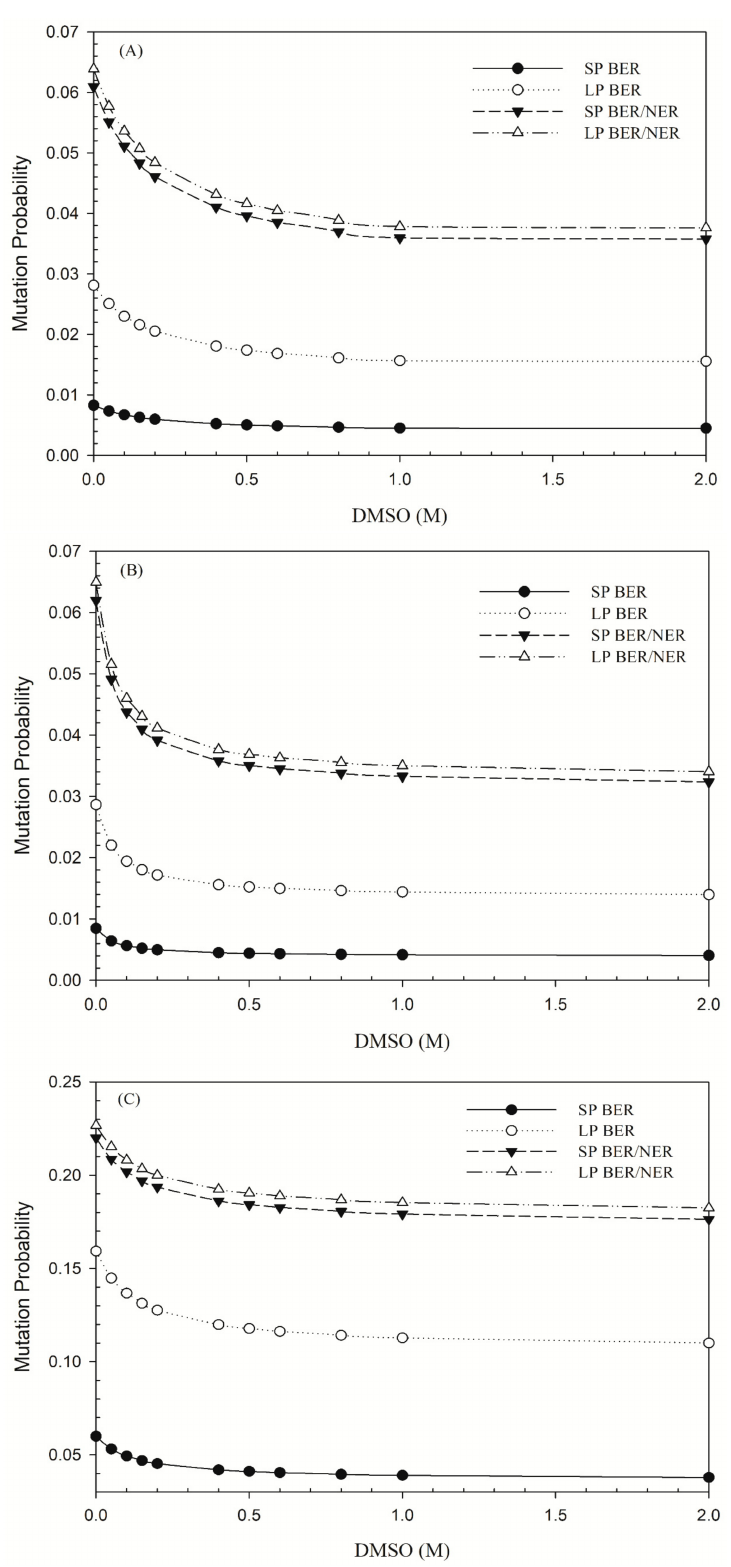
Figure 3. Mutation frequency (per Gy per cell) as a function of the concentration of DMSO for cells irradiated by ( A ) 60 Co γ -rays (LET = 2.4 keV/ µ m), ( B ) 62 MeV proton ions (LET = 1.051 keV/ µ m) and ( C ) 3.31 MeV helium ions (LET = 120 keV/ µ m). All four pathways (SP BER, LP BER, NER/SP BER and NER/LP BER) were